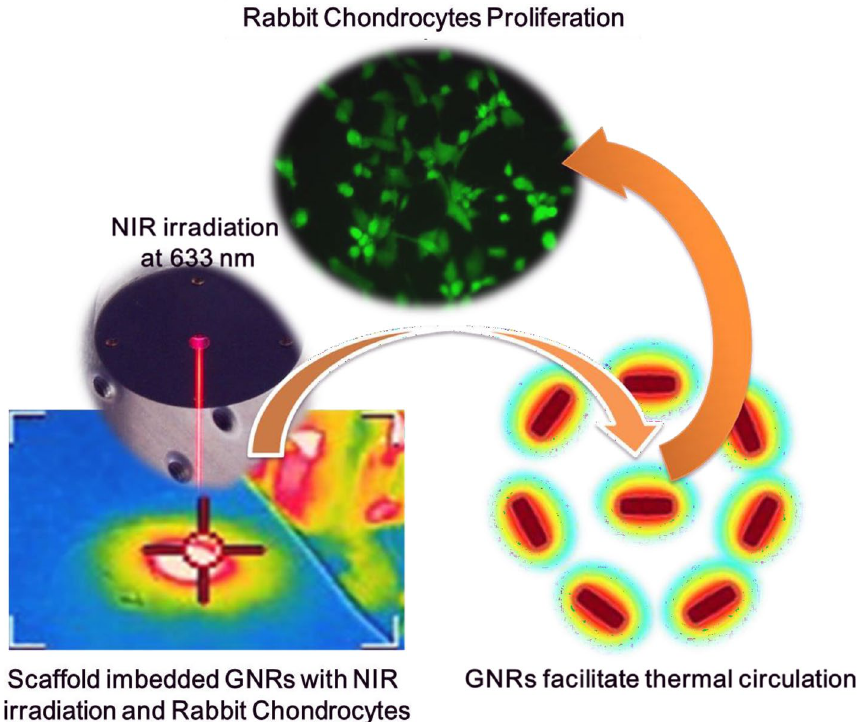
Figure 1. Schematic illustration of fabricating the biocompatible scaffold imbedded GNRs with NIR irradiation. Rabbit chondrocytes were seeded in scaffold imbedded GNRs with NIR irradiation at 633 nm laser. Rabbit chondrocyte proliferation occurred due to thermal circulation of